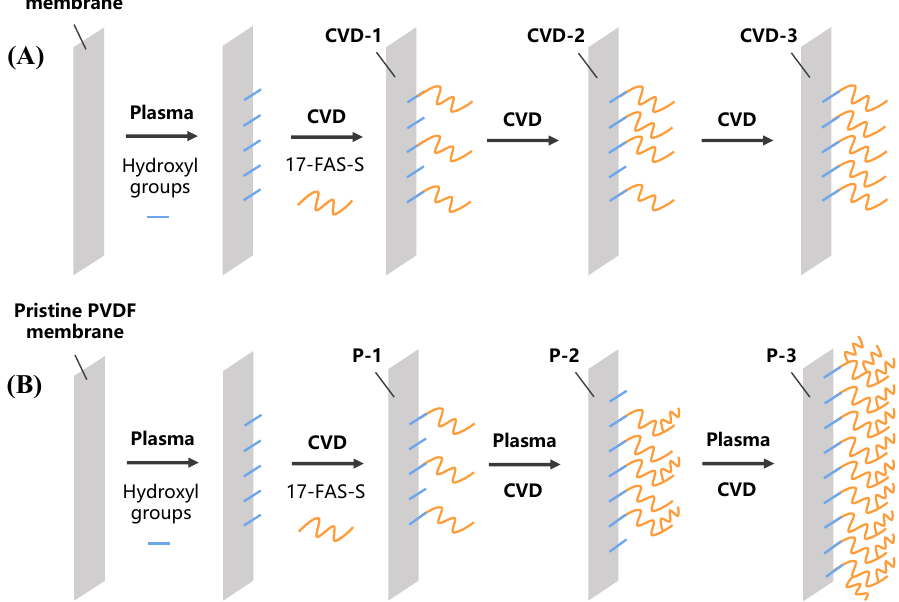
Figure 1. The procedure of repeated plasma-CVD modification strategies. ( A ) Modification process with multiple CVD steps and ( B ) modification process with multiple plasma-CVD cycles.